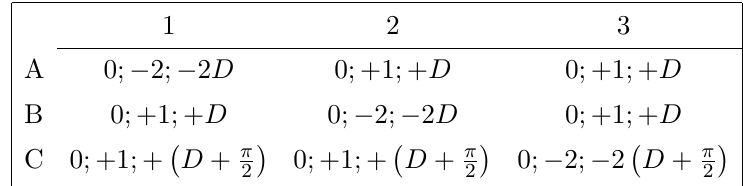
Table 2 . The power-law IR divergences of diagrams A1, A2,